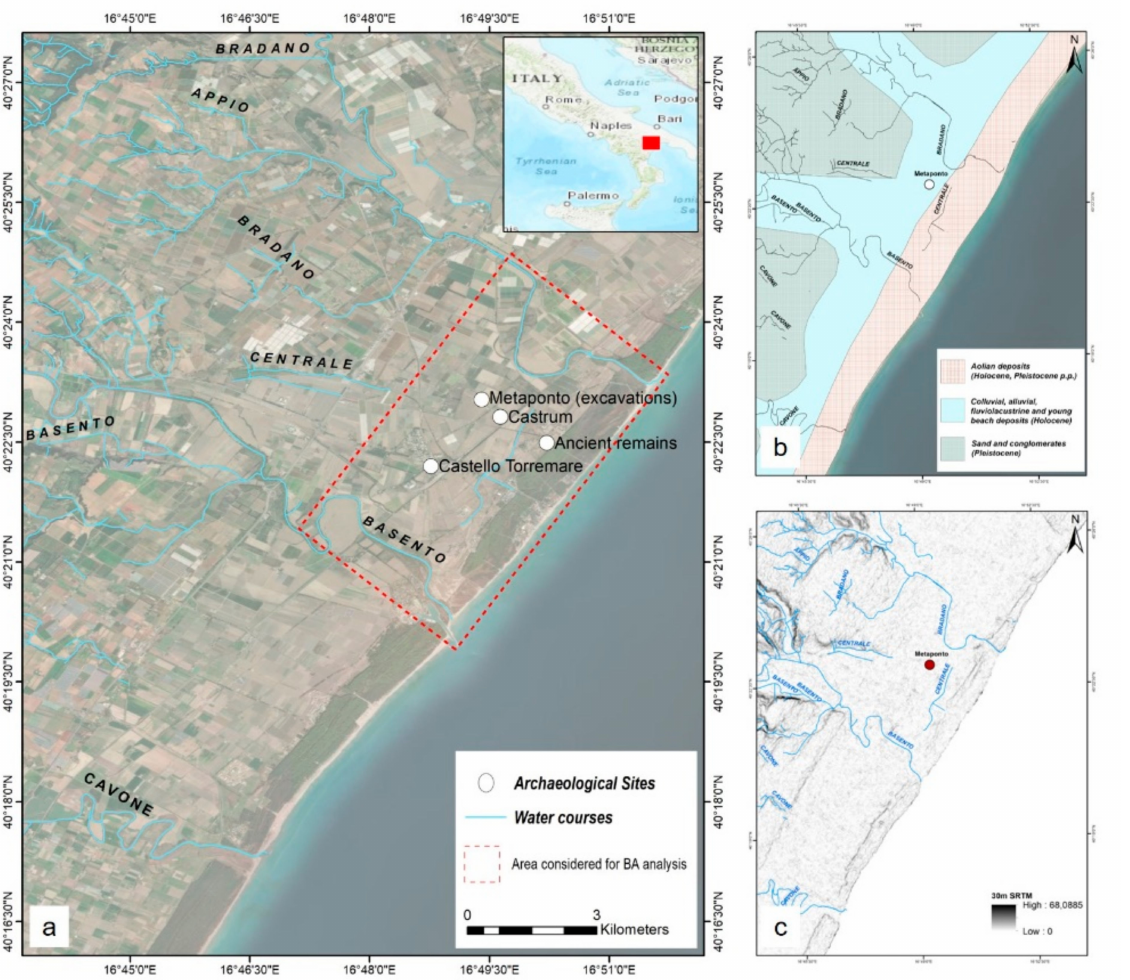
Figure 1. ( a ) Study area; ( b ) Geological map; ( c ) 30 m SRTM (Shuttle Radar Topography